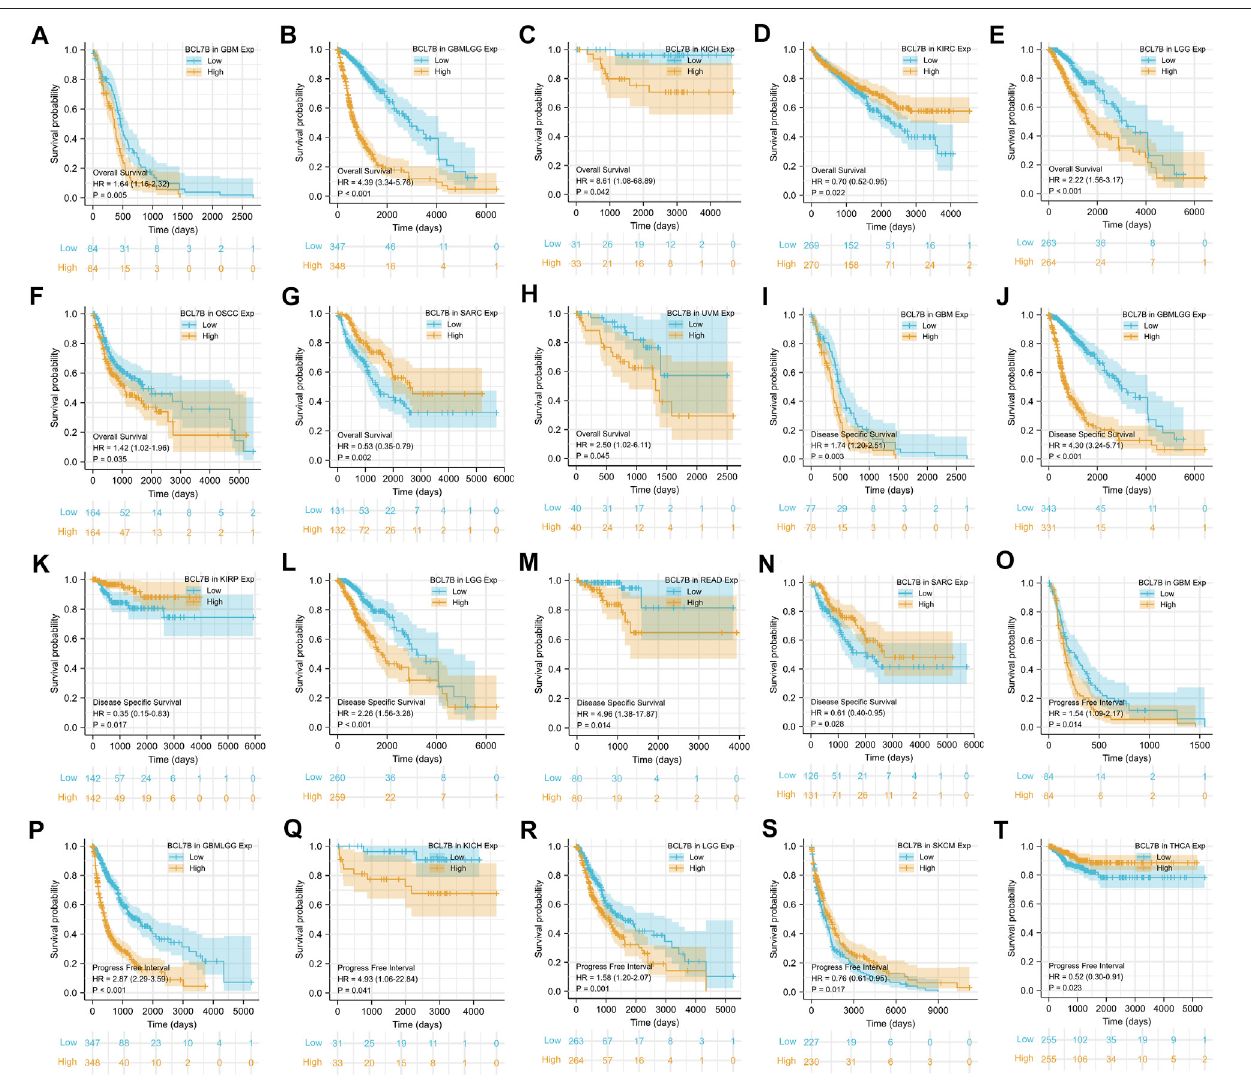
FIGURE2| Survivalcurvesofcancertypeswithsigni fi cantcorrelationbetween BCL7B geneexpressionandprognosis.Highexpressionof BCL7B wasassociatedwithan inferiorprognosisinGBM( p =0.005) (A,I,O) ,GBMLGG( p < 0.001) (B,J,P) ,KICH( p =0.042) (C,Q) ,LGG( p < 0.001) (E,L,R) ,OSCC( p =0.035) (F) ,READ( p =0.014) (M) ,and UVM( p =0.045) (H) .Lowexpressionof BCL7B wasassociatedwithapoorprognosisinKIRC( p =0.022) (D) ,KIRP( p =0.017) (K) ,SKCM( p =0.017) (S) ,THCA( p =0.023) (T) , and SARC ( p = 0.002) (G,N) .